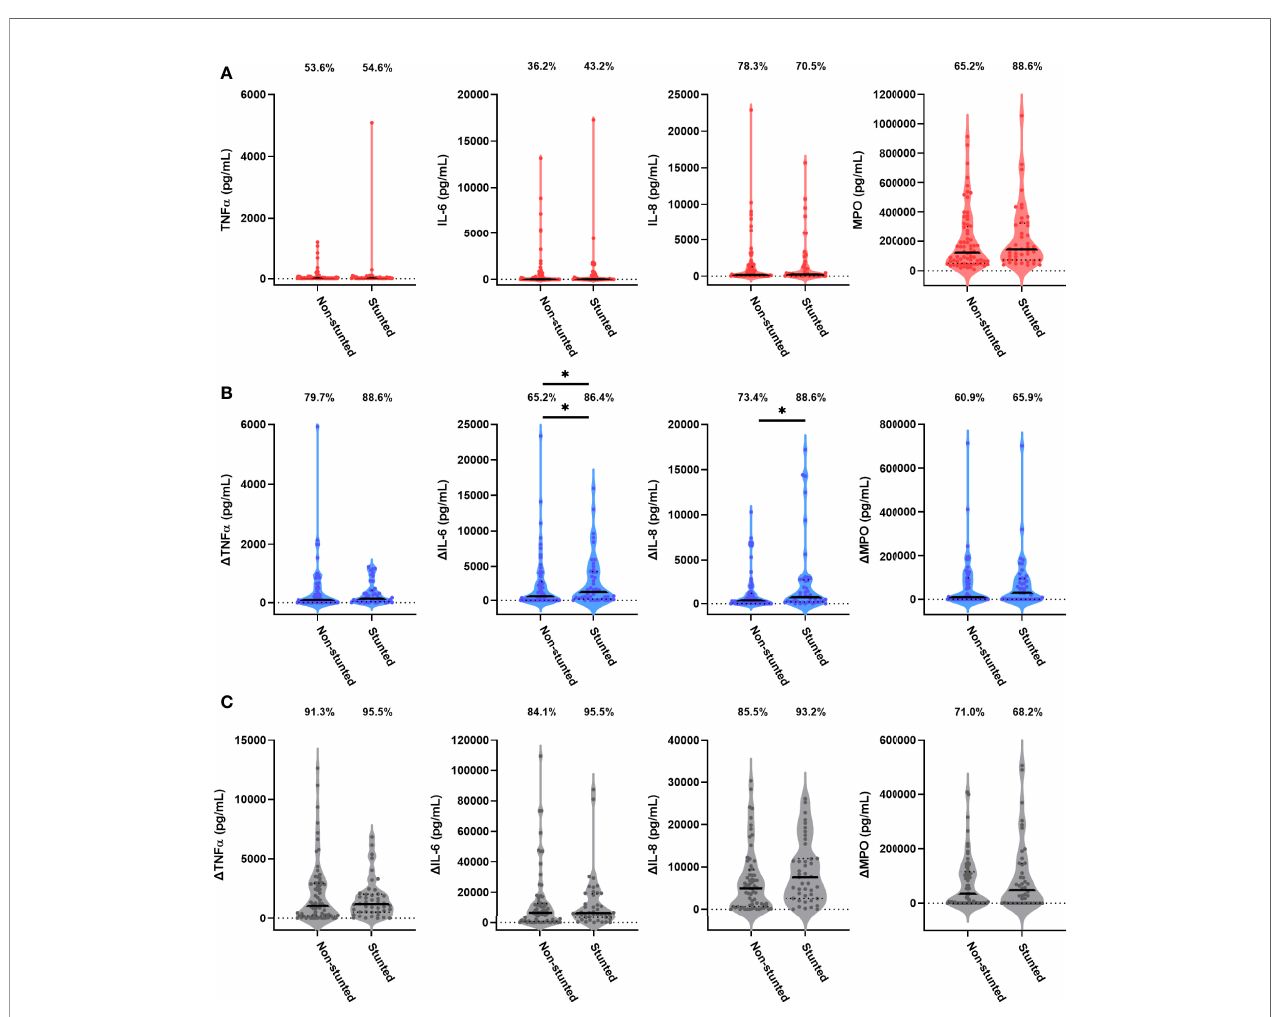
FIGURE 3 | Unstimulated and bacterial antigen-stimulated immune-mediator production by blood immune cells from stunted versus non-stunted children. Violin plots (median and interquartile range indicated) of (A) unstimulated (red), (B) LPS-stimulated (blue) and (C) HKST-stimulated (grey) TNF a , IL-6, IL-8 and MPO concentrations in 24h culture supernatants. LPS- and HKST-speci fi c concentrations ( D ) were calculated for each child by subtracting concentrations present in matched unstimulated culture supernatants. Proportions indicate participants with mediator concentration > ELISA limit of detection (A) and participants with antigen-stimulated mediator concentration > unstimulated (B, C) . Proportions of children with detectable mediator levels and mediator concentrations were compared by stunting status (stunted n = 44 versus non-stunted n = 69) via multinomial logit regression and censored log-normal (tobit) regression, respectively (unadjusted analyses indicated; full results in Table 2 ); *p <